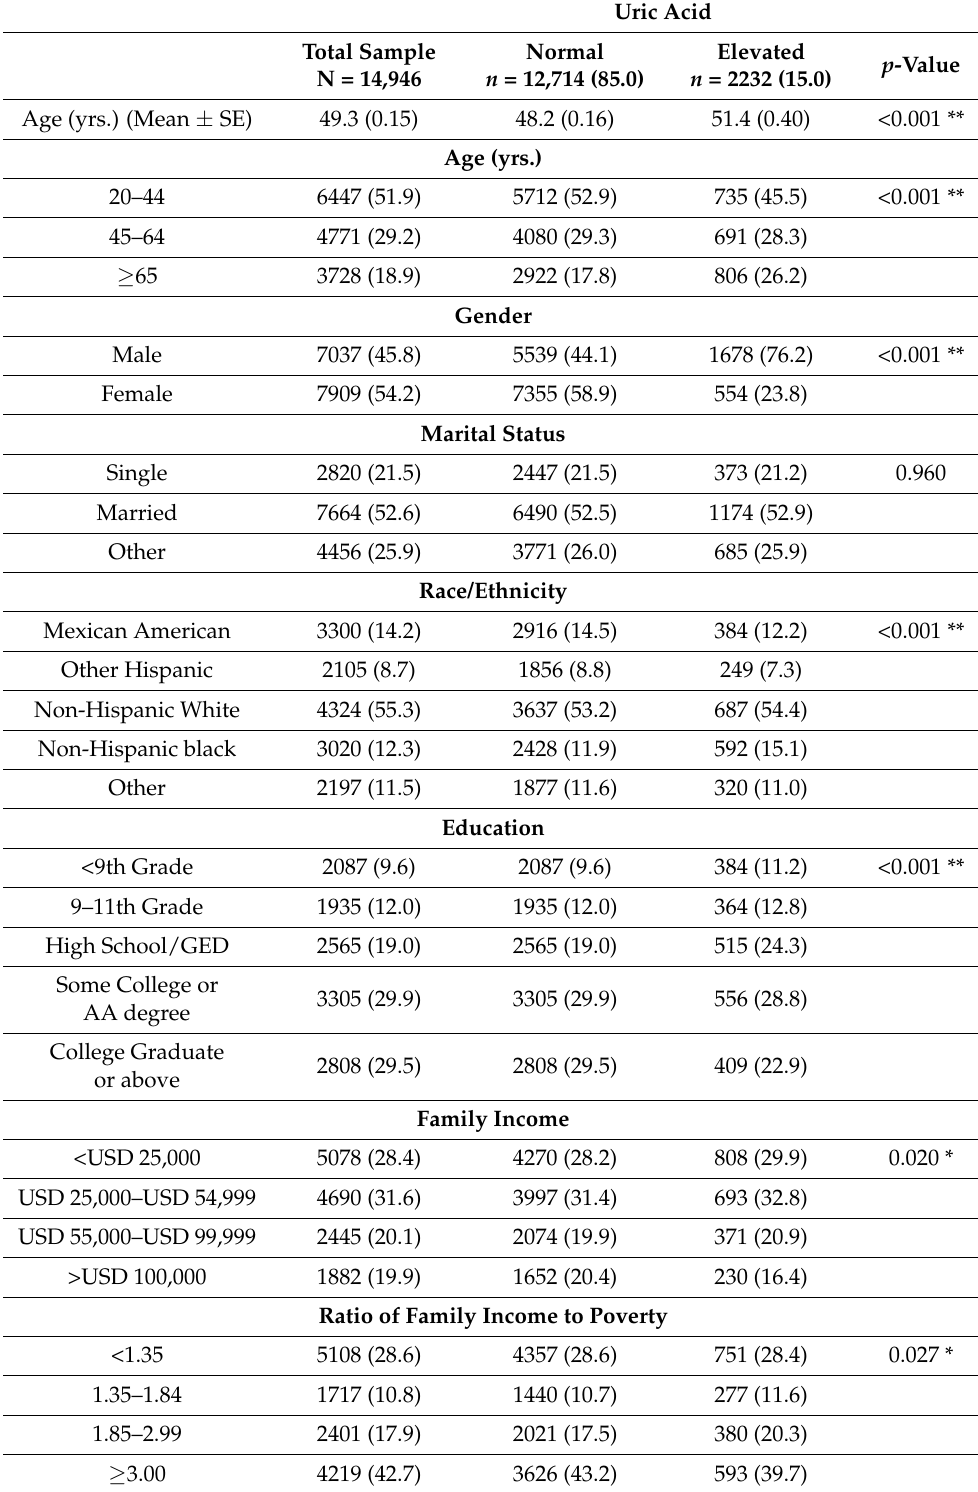
Table 1. Demographic Characteristics and Laboratory Data of NHANES participants